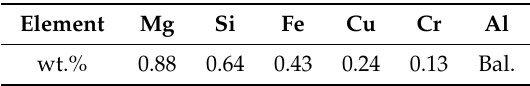
Table 1. The nominal compositions of 6061 sheet